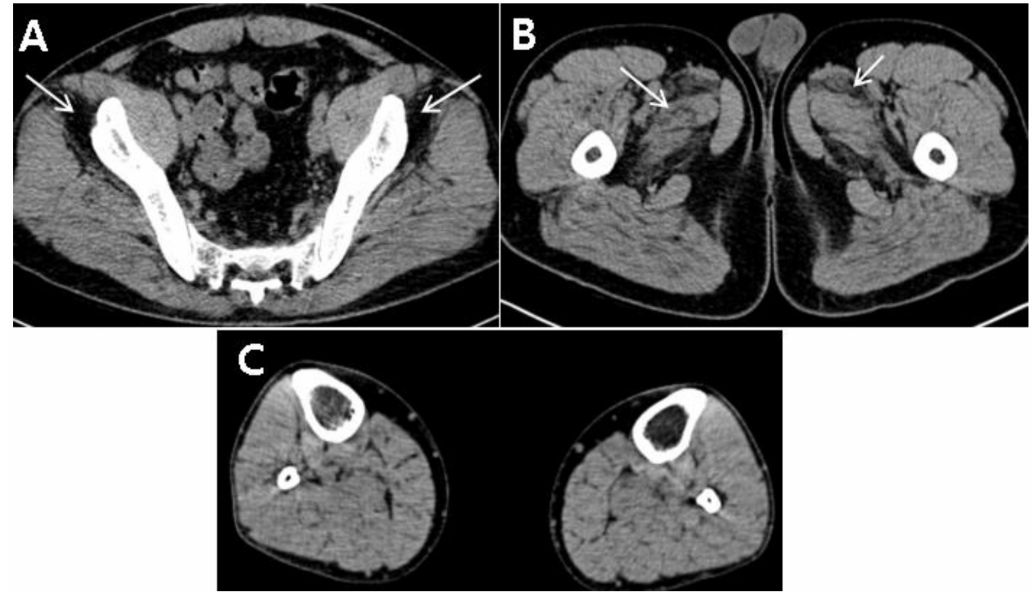
Figure 2. A computed tomography (CT) scan of the lower extremities. ( A ) Severe fatty degeneration of the gluteus minimus (arrows) on muscle computed tomography (CT). ( B ) Mild fatty degeneration of the adductor longus and brevis (arrows) on CT. ( C ) No definite fatty degeneration of the posterior compartment of the distal lower limb on